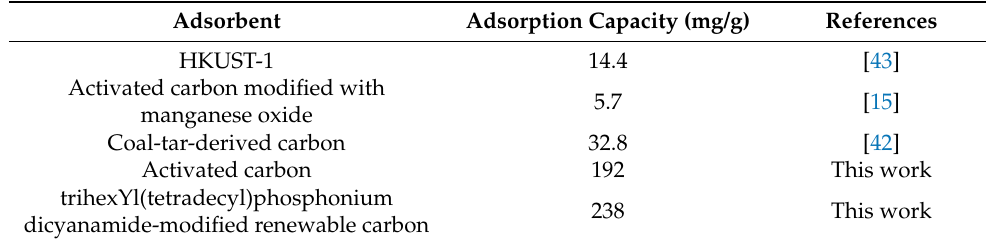
Table 3. Comparison of the adsorption capacities for the removal of benzothiophene onto activated carbon and trihexYl(tetradecyl)phosphonium dicyanamide-modified renewable carbon with those of other adsorbents.